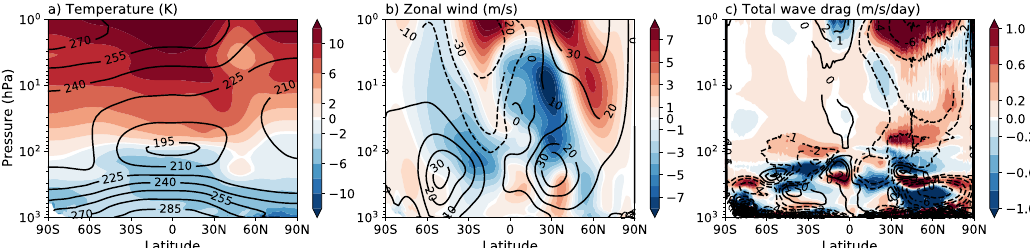
Figure 6. Zonal-mean ( a ) temperature, ( b ) zonal wind, and ( c ) wave drag, averaged in December, January, and February, for the simulations of modern climate without ozone depletion substance (MC no_ODS ) (black contours) and the corresponding difference between LGM PMIP3 and MC no_ODS (colored shading). Positive (negative) changes in the negative (positive) climatology regions in (c) indicate that the absolute wave drag becomes smaller in LGM PMIP3 . Table 2. SSW frequency (#/year), the time when the first SSW event appears, and the mean final warming day (January 1 is day 1) from the MC no_ODS , MC, PI, LGM PROXY , and LGM PMIP3 simulations. The standard deviation of the final warming day follows the ± sign.